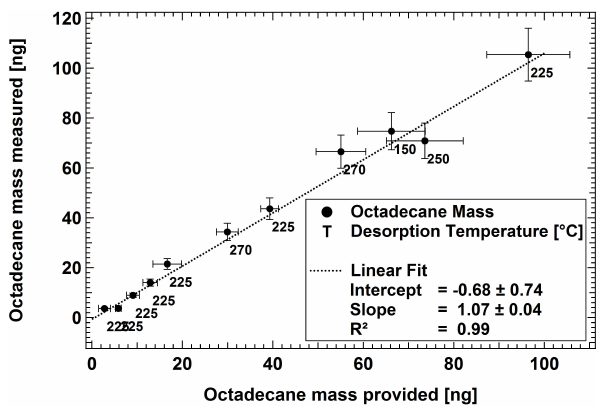
Fig. 4. Octadecane mass measured with the GC-FID vs. the collec- tor loading (calculated from SMPS measurements) together with a linear fit through data points. Numbers show the desorption tem- peratures for each